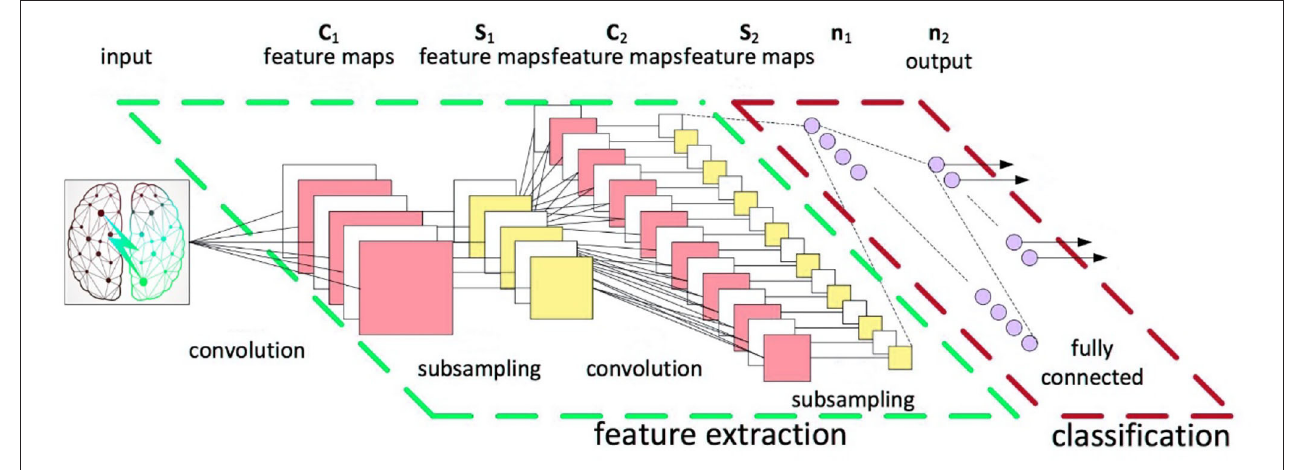
FIGURE 2 | CNN calculation